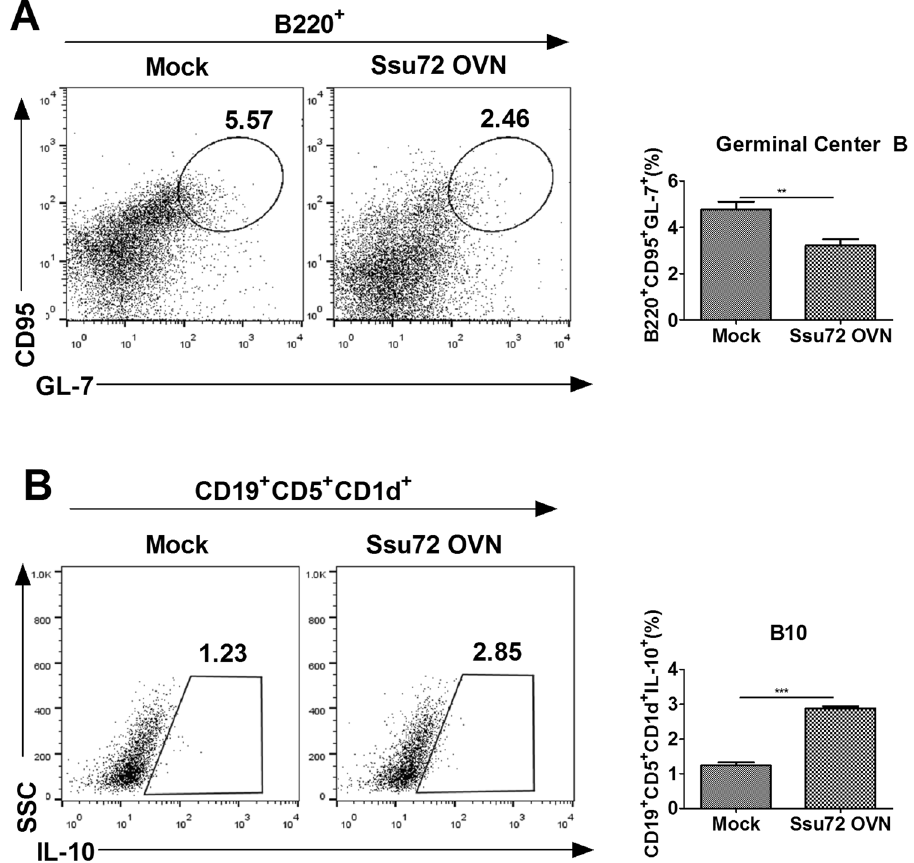
Figure 6. Ssu72 overexpression exerts therapeutic effects on CIA in an in vivo model by controlling B cell responses. ( A ) The populations of GL-7-producing B220 + CD95 + B cells in splenocytes from mice with CIA (mock or Ssu72-overexpressing) were analyzed by intracellular flow cytometry. ( B ) Populations of IL-10- producing CD19 + CD5 + CD1d + B cells in splenocytes from mice with CIA were analyzed by intracellular flow cytometry. The data represent the mean ± SD from three independent experiments. Statistical analyses were conducted using the nonparametric Mann-Whitney U -test ( ** P < 0.03, *** P < 0.01, n =